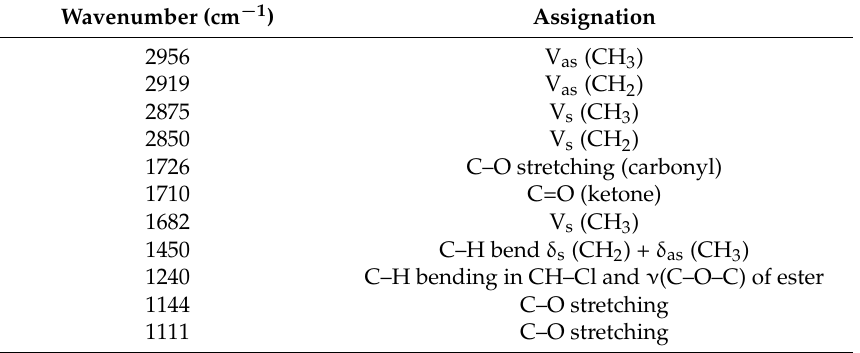
Table 3. Identification of most important peaks in FTIR-ATR spectrum of acrylic paint